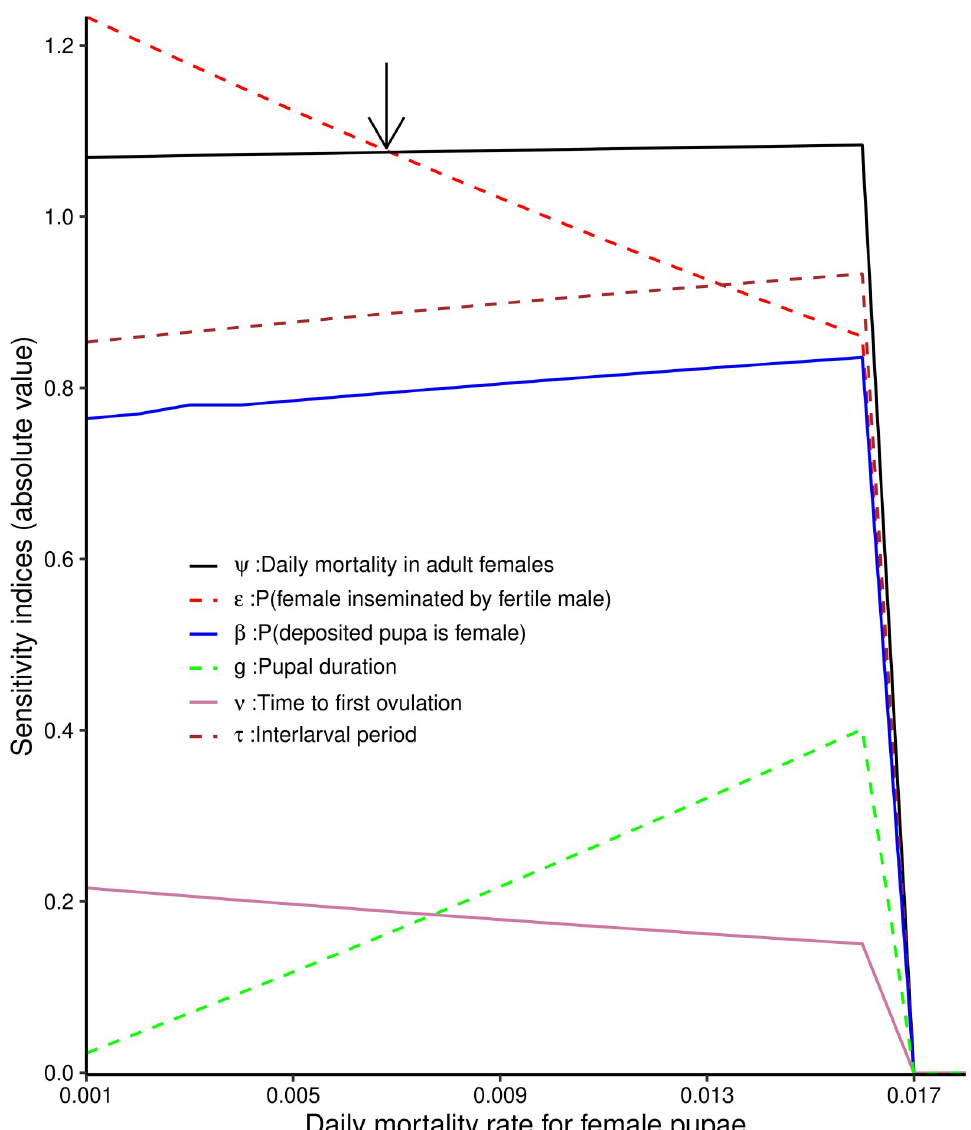
Fig 1. Variation in the sensitivity of extinction probability θ to six input parameters ( β , � , ν , g , ψ , τ ) as a function of the values of the background daily rate ( χ ) of pupal female mortality. The sensitivity indices of extinction probability to six input parameters, in absolute value. The arrow through the plot indicates the point where θ becomes more sensitive to ψ than � . respect to the six remaining input parameters for different values of χ . Fig 1 shows changes in the sensitivity indices of θ with respect to each parameter as the daily mortality rate for female pupae ( χ ) varies from 0.1% to 2.5%, while keeping the other baseline values constant (Table 2).